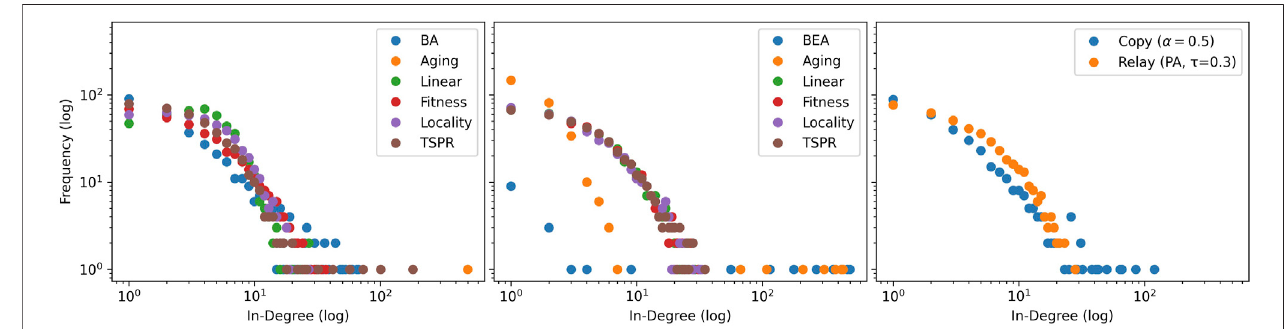
FIGURE 1 | Mode-averaged in-degree distributions for simulated sum-normalized (left) , softmax-normalized(centre), and other baseline models (right) . 50 iterations of 500 node steps are run per model. Models in the same iteration number use identical, pre-drawn out-degree counts from | E n | ∼ Po ( 5 ) and subjects from ϕ ∼ Dir (cid:8) 1 , 30 (cid:9) 30